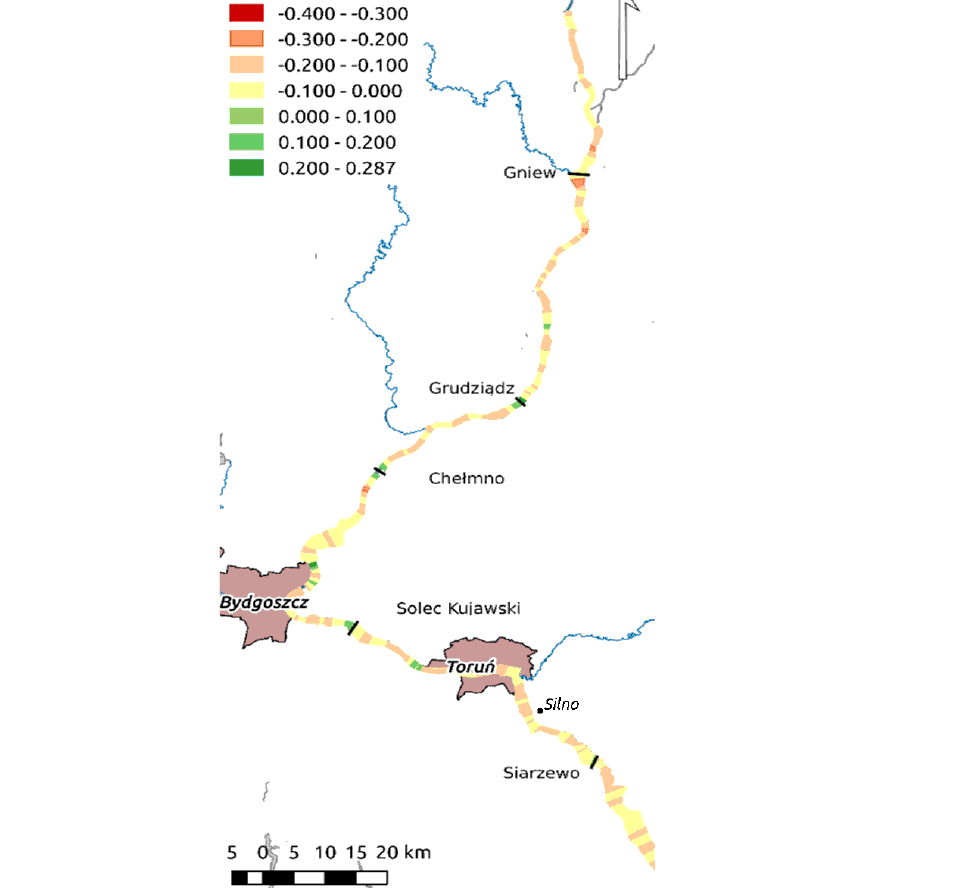
879.009 after seven years of its operation. This means that it moved the distance